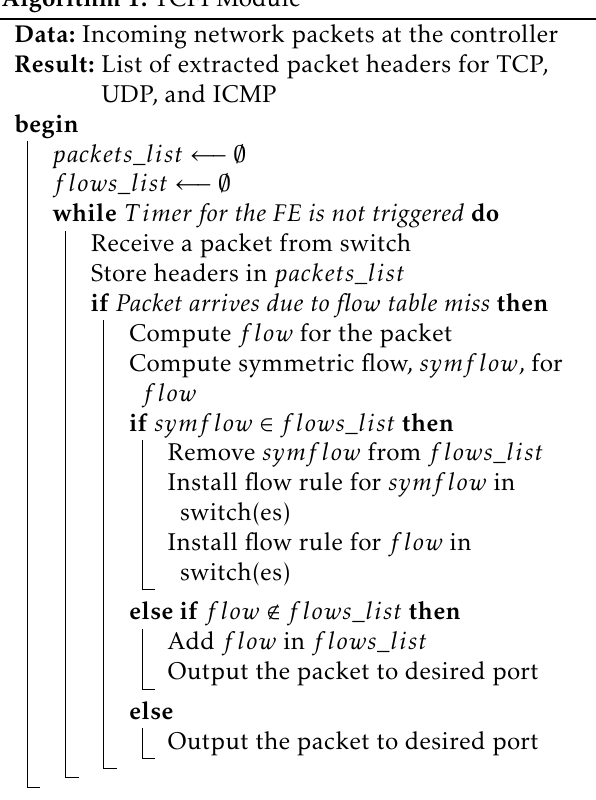
Algorithm 1: TCFI